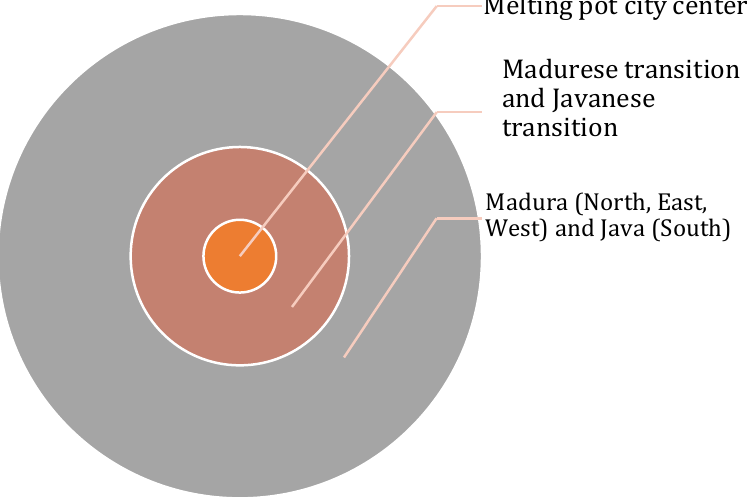
Fig. 1 Hibridity of Pendalungan culture